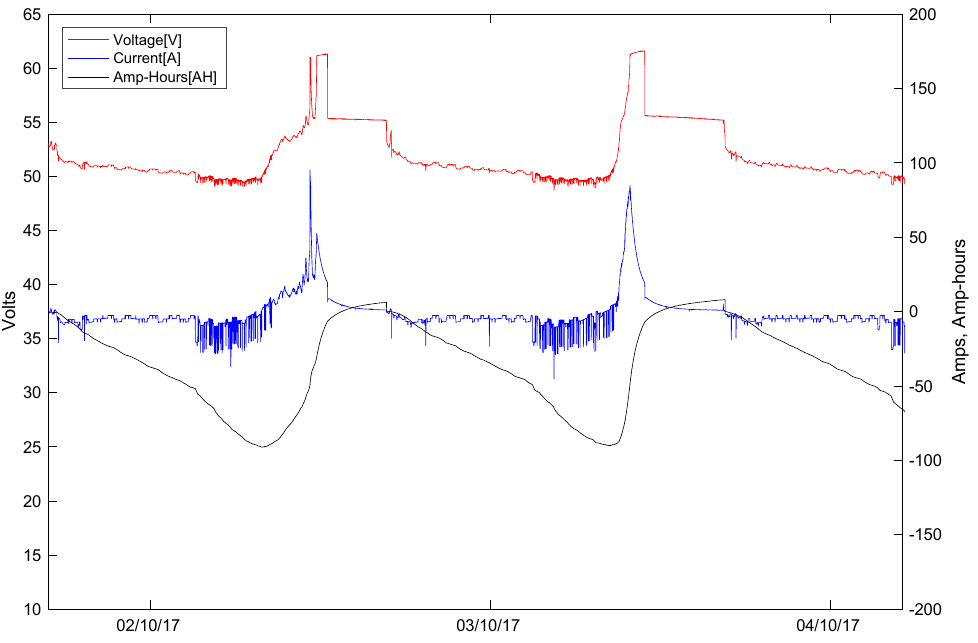
Figure 4. Normal solar charging in October showing absorption CV charge regulation at 61 V (at 15 °C) with a transition to float CV charge regulation at 55 V (at 15 °C) when I < 20 A.